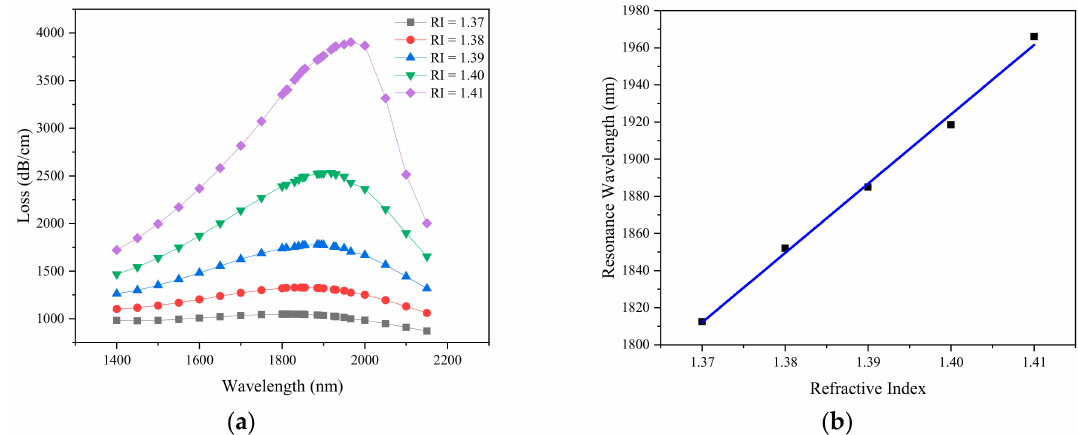
Figure 5. ( a ) Loss spectra obtained by simulation when analyte RI is 1.37–1.41; ( b ) Linear fitting between resonance wavelength and analyte RI. ( d 1 = 0.5 µ m, d 2 = 0.7 µ m, d 3 = 1 µ m, Λ = 2 µ m, ts = 30 nm, L = 1). Table 1. Maximum confinement loss for different analyte RIs and average sensitivity of the sensor. Confinement Loss (dB/cm) Average Sensitivity The Number of Layers of Graphene (nm/RIU)RI = 1.37 RI = 1.38 RI = 1.39 RI = 1.40 RI = 1.41 L = 1 1049.03 1327.71 1776.89 2531.53 3903.90